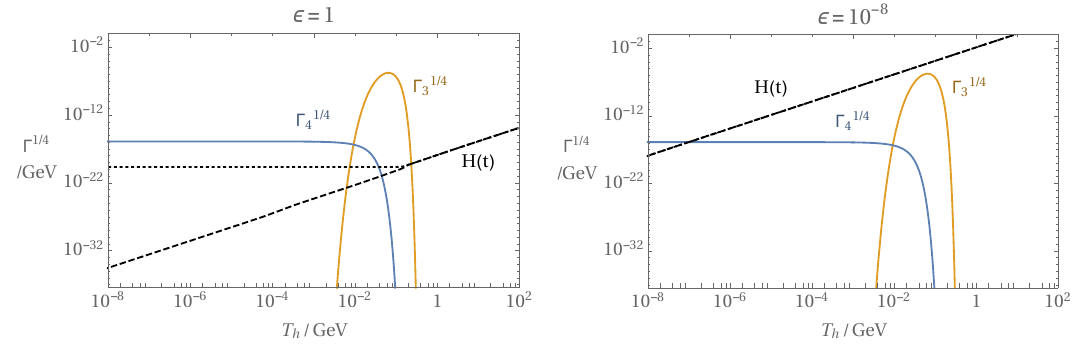
Figure 4 . The bubble nucleation rate as a function of the hidden sector temperature for a model with g = 2 and ~ m 2 = 0 : 04 (as in the left panel of (cid:12)gure 2) and w = 1 GeV. Results are shown for a hidden sector at the same temperature as the visible sector ( (cid:15) = 1, left) and for a hidden sector that is much colder ( (cid:15) = 10 (cid:0) 8 , right). The Hubble parameter in the two cases is also plotted, assuming that the transition occurs prior to the hidden sector false vacuum energy dominating the energy density of the universe (dashed black), and assuming the phase transition does not complete prior to this (dotted black). If (cid:15) = 1 (left panel) the hidden sector false vacuum energy begins to dominate at T v = T h ’ 0 : 2 GeV when the two Hubble curves diverge. A transition happens when H ( t ) is (cid:12)rst smaller than one of (cid:0) 1 = 4 or (cid:0) 1 = 4 . Therefore the warm hidden sector (left) undergoes 3 4 a thermally nucleated transition, while the cold hidden sector (right) misses a thermal transition, but subsequently goes through a tunnelling